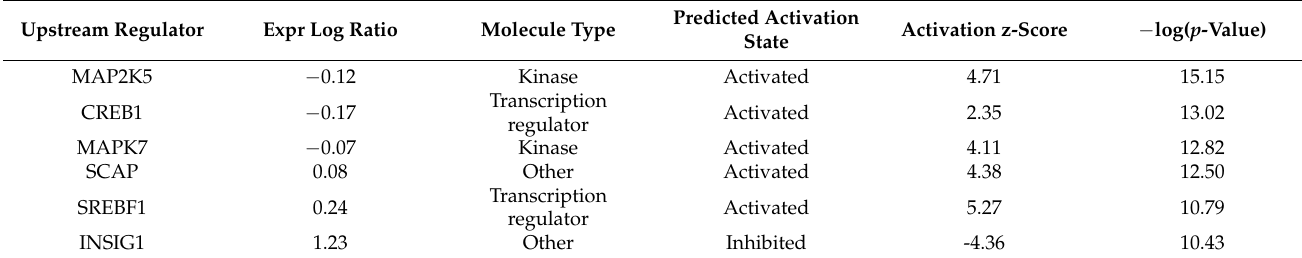
Figure 9. ( A ) Canonical pathway analysis by IPA for w/o TNF α . ( A ) Ten first entries. ( B ) Gene expression of genes involved in cholesterol biosynthesis (w/o TNF α dataset); expression is displayed as a bar, while significance, expressed as − log10( p -value), is reported in orange. ( C ) RT-qPCR results for gene expression in w/ TNF α fibroblasts after 1 × and 0.5 × ADNV treatment (** p < 0.01, *** p < 0.001). Table 7. Upstream Regulator list by IPA for w/o TNF α dataset.